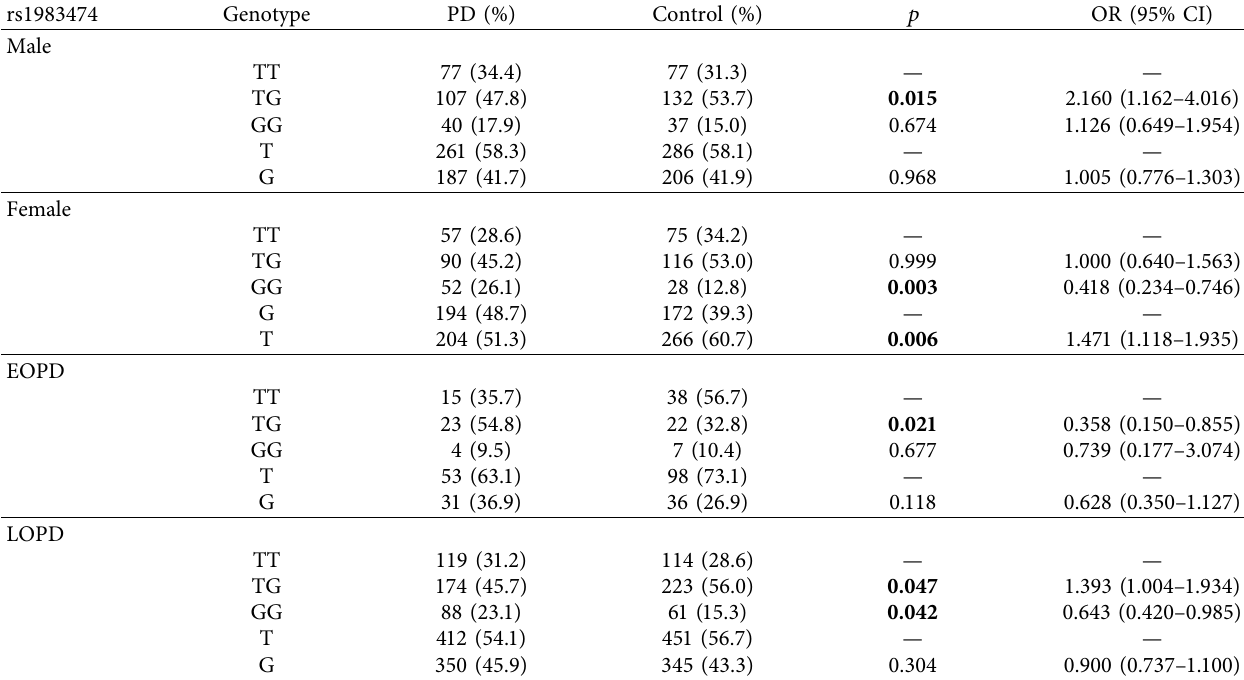
Table 6: Distribution of rs1983474 polymorphism in different subcomponent types.